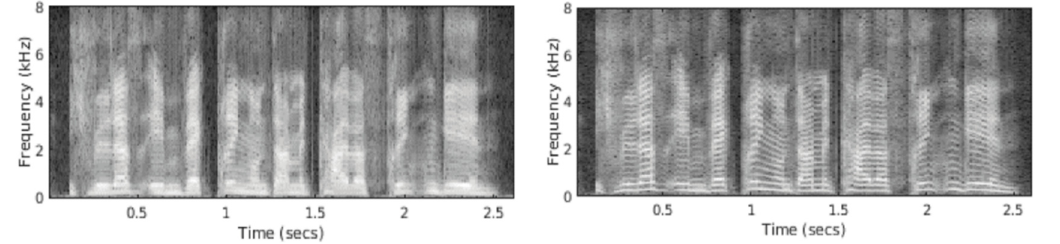
Figure 1. Spectrograms constructed using different window lengths; left 10 ms, right 30 ms.